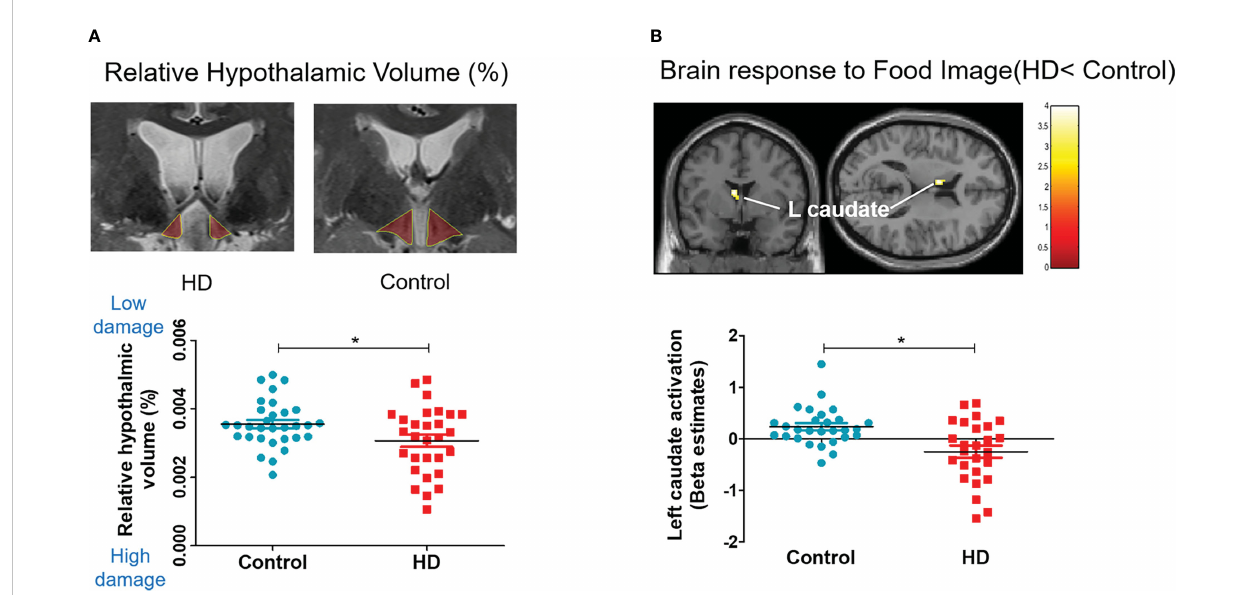
FIGURE 3 Hypothalamic damage and whole-brain response to food. Scatter plots for relative hypothalamic volume and brain response difference in the HD and control groups. The unpaired, two-sample Student ’ s t -test was used for comparing the HD and control groups. (A) Relative volume: